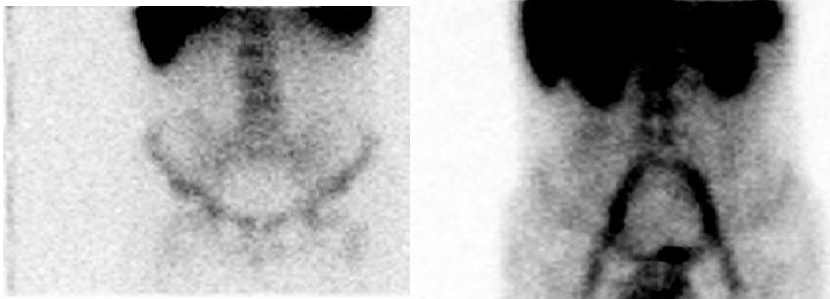
Figure 3. Comparison of 111 In-oxine labeled leukocyte scan (left) and 99mTc-labeled human immunoglobulin G scan (right) in the same patient (anterior view). Pathological uptake of both radiopharmaceuticals on the ascending colon; only labeled immunoglobulin scan shows pathological uptake on descending colon.